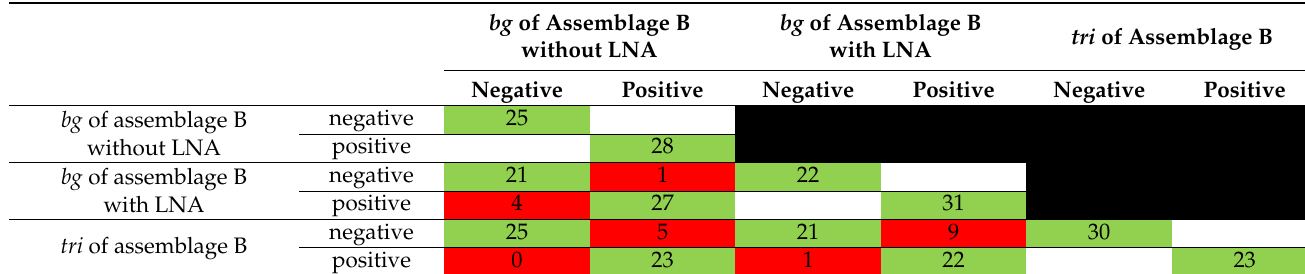
Table A6. Cross-table detailing mismatches between the real-time differentiation PCR assays targeting the G. duodenalis assemblage B. Green = matching results. Red = mismatching results. Black = not filled in to avoid